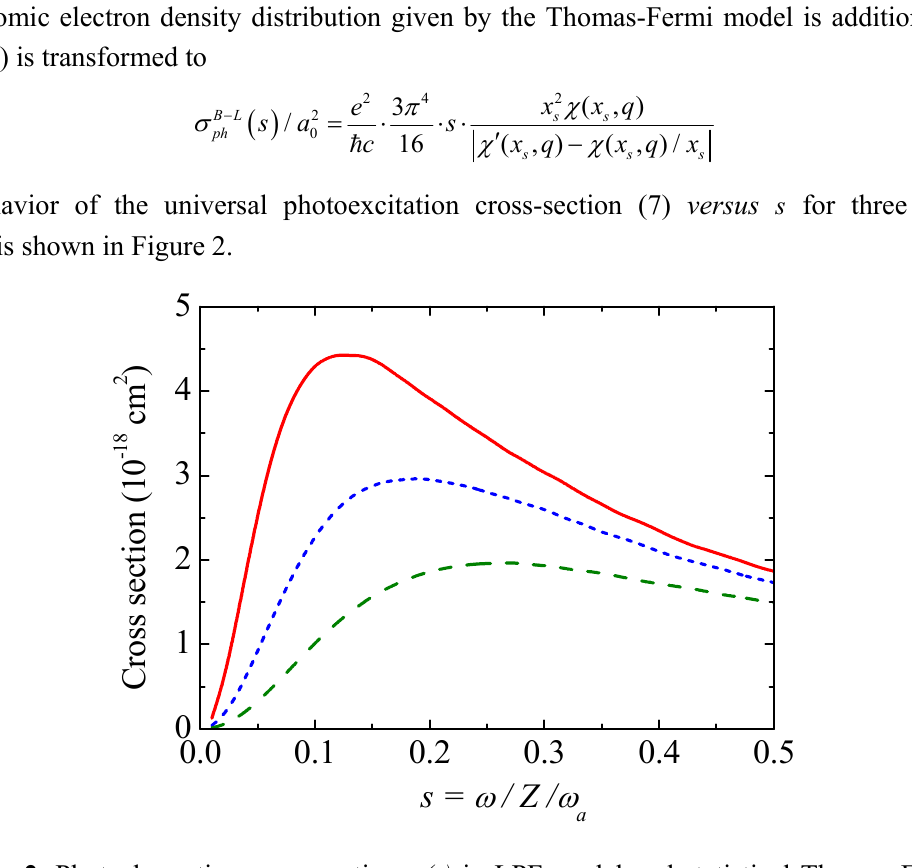
Figure 2. Photoabsorption cross-section σ (s) in LPF model and statistical Thomas-Fermi model versus the reduced frequency s = ω /Z/ ω a for three values of q : solid (red) curve— q = 0.3; short dashed (blue) curve— q = 0.4; long dashed (green) curve— q =